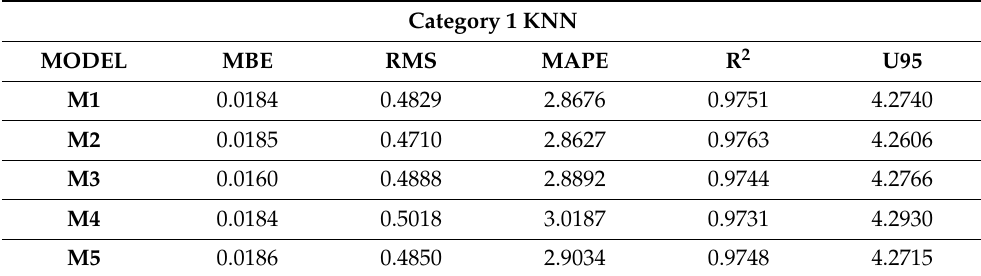
Table 3. Values of statistical indicators for the developed models.